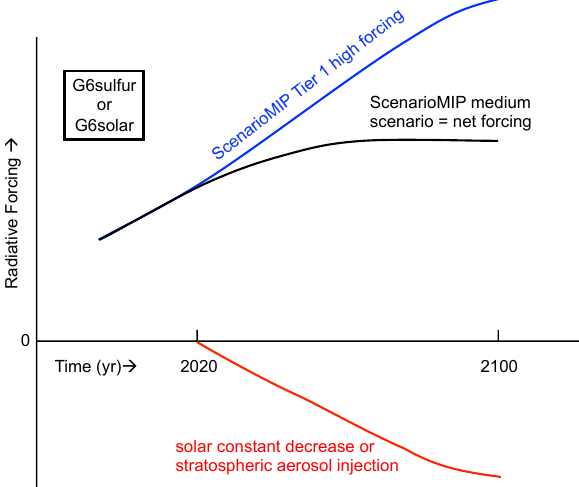
Figure 2. Schematic of experiments G6sulfur and G6solar. Against a background of the ScenarioMIP Tier 1 high forcing scenario, geo- engineering will be conducted at time-varying amounts to return net anthropogenic radiative forcing to the levels of the ScenarioMIP Tier 1 medium forcing scenario. Geoengineering will be accom- plished by stratospheric aerosol injection (G6sulfur) or solar irradi- ance reduction